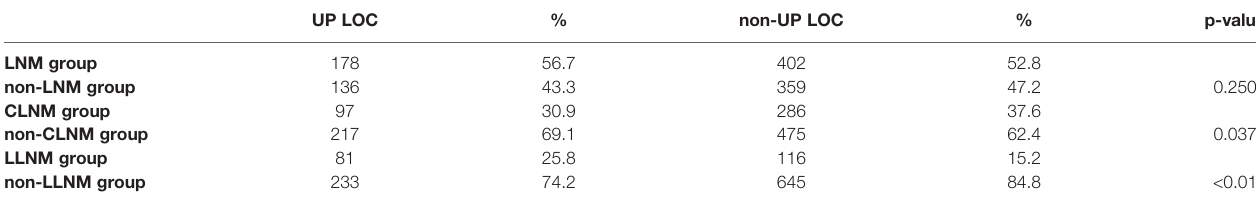
TABLE 2 | Characteristics of tumor location and LNM in PTC patients.